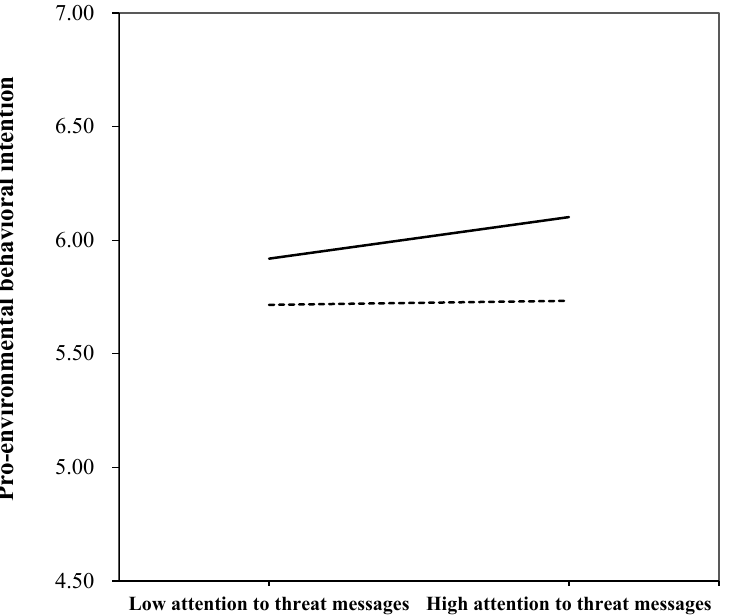
Figure 4. ( a ) Pro-environmental behavior intention by attention to efficacy messages and threat messages, when perceived behavioral control is low. ( b ) Pro-environmental behavior intention by attention to efficacy messages and threat messages, when perceived behavioral control is high.